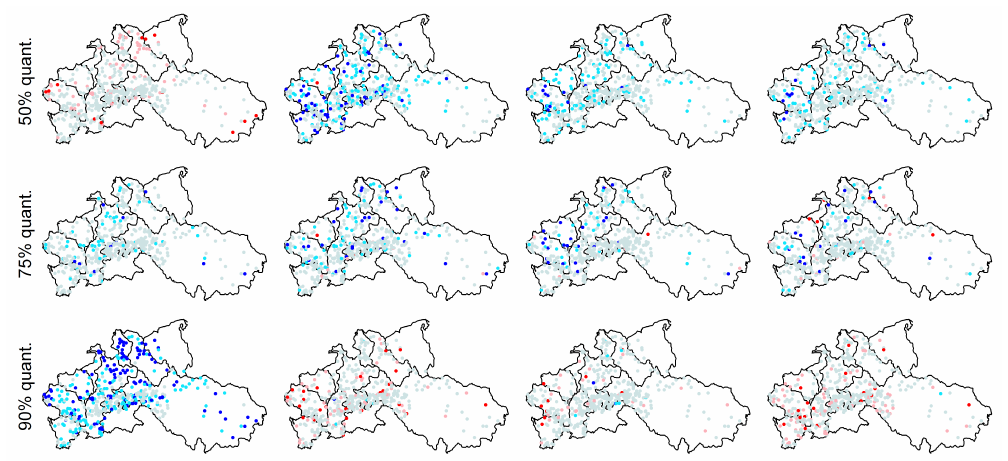
Figure 18. Spatial distribution of bias of summary statistics reported in Figure 17. Positive (negative) values denote model overestimation